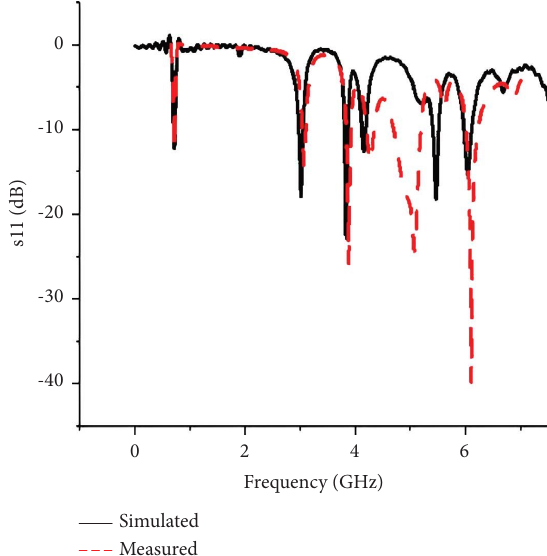
Figure 12: Simulated vs. measured results of S